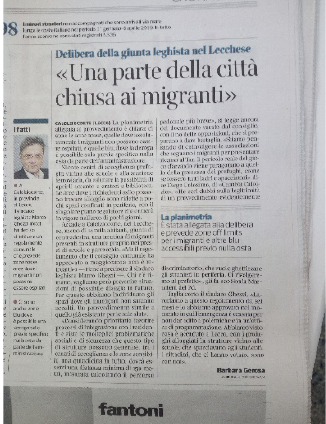
Figure 2: A national newspaper announcing, 'A part of the city closed to migrants' (Corriere della Sera, April 11 th ,